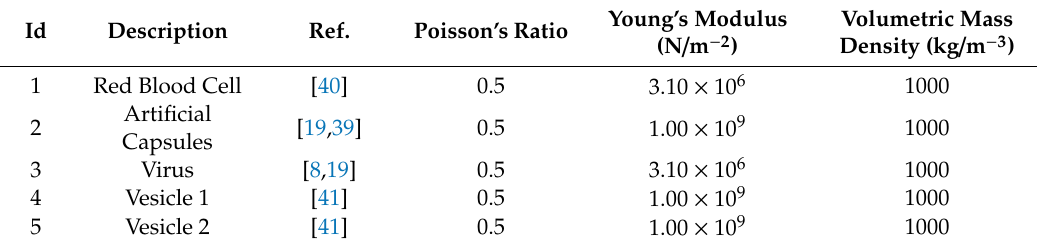
Table A7. Material properties of the compliant micro-scale thin shells included in the study.